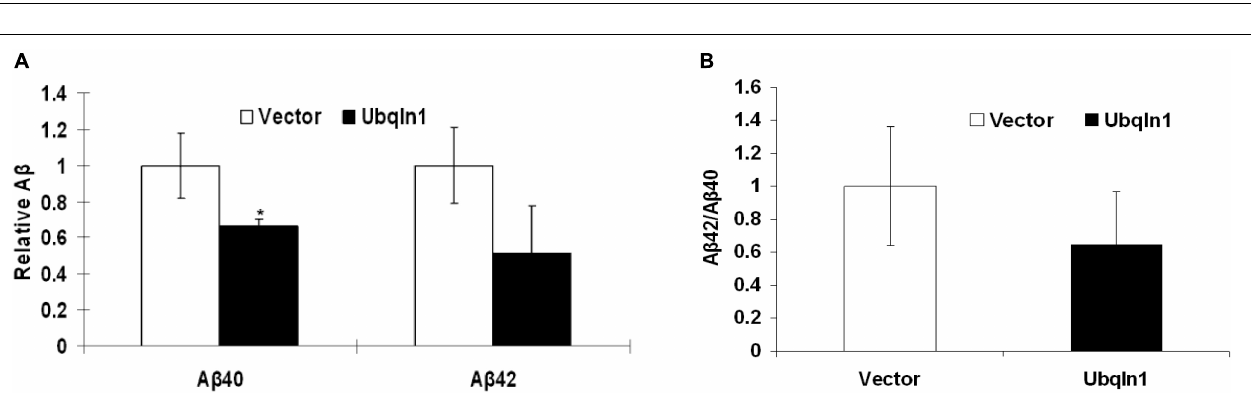
FIGURE 3 | Down-regulation of ubiquilin-1 decreases cell viability and elevates caspase-3 activity. (A) Ubiquilin-1 knock-down significantly decreased cell viability in SY5Y-APP-Gal4 cells utilizing the MTT assay ( p < 0.05). SY5Y-APP-Gal4 cells stably expressing the control (a non-specific shRNA not targeting any known genes) and shUbqln1 were incubated with 500 µ M H 2 O 2 for 1 h, and then subjected to MTT assay to measure cell viability. (B) Ubiquilin-1 knock-down significantly elevates caspase-3 activity. SY5Y-APP-Gal4 cells stably expressing the control and shUbqln1 were incubated with 500 µ M H 2 O 2 for 1 h, and then utilized in a caspase-3 activity assay (* p < 0.05). The caspase-3 activity of shUbqln1 cells was compared to control cells.